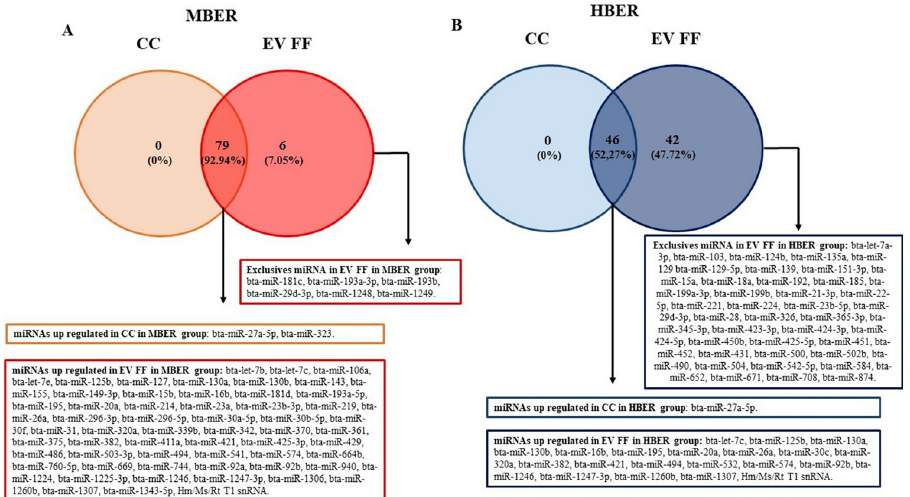
Fig 5. Total numbers of miRNAs detected in cumulus cells (CC) and follicular fluid extracellular vesicles (EV FF) from 3–6 mm follicles from cows with different body energy reserve. A. Venn diagram demonstrating a total of 79 miRNAs commonly detected between CC and EV FF for MBER group, which 2 were up regulated in CC samples and 60 up regulated in EV FF and, 6 exclusively detected miRNAs in EV FF but not in CC. B. Venn diagram demonstrating a total of 46 miRNAs commonly detected between CC and EV FF for HBER group, only 1 was up regulated in CC samples and 21 up regulated in EVs FF and, a total of 42 exclusively detected miRNAs in EV FF but not in